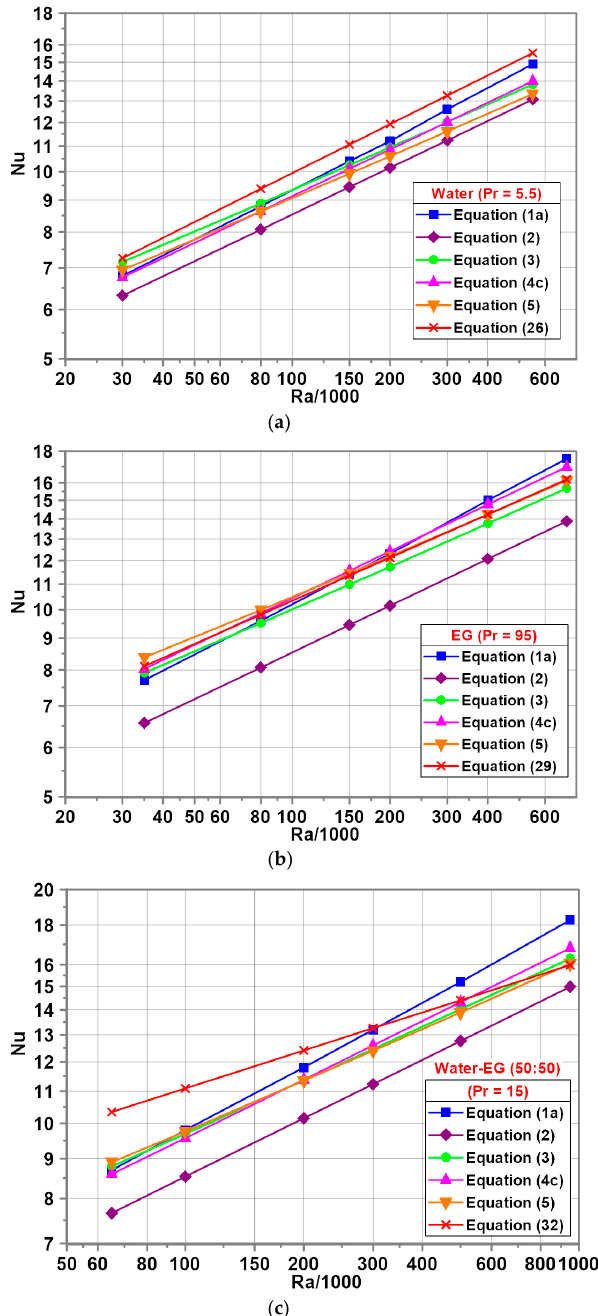
Figure 5. Present Nu-Ra relationship vs. predictions from literature correlations for water ( a ), EG ( b ), and water-EG (50:50) ( c ) The best match with the predictions from Equation (29) is shown to be the correlation equation proposed by Fand and Brucker (Equation (5)) with an average deviation of about ± 1.2%. The biggest discrepancy is found in the correlation equation proposed by Morgan (Equation (2)), with about 19% deviation for the minimum Ra